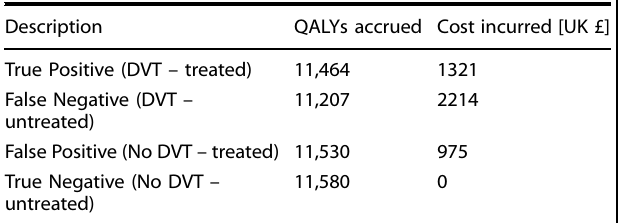
Table 14. Estimated QALYs accrued, and costs incurred for each diagnostic accuracy outcome.